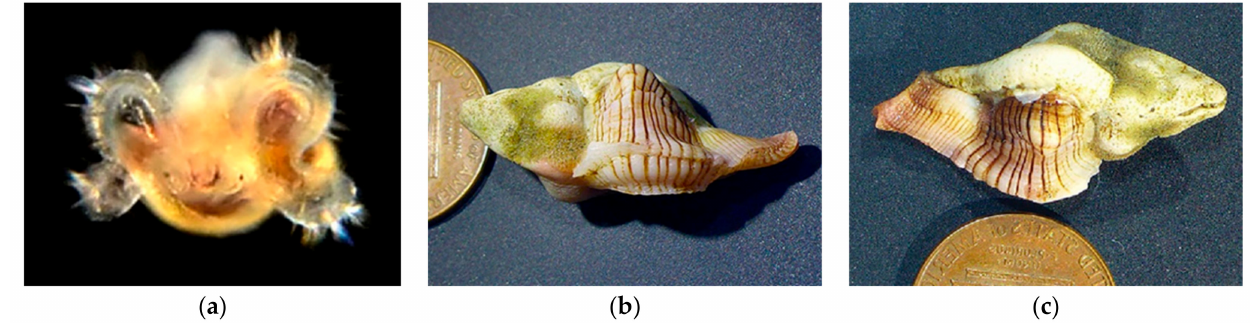
Figure 16. Family Muricidae. Festive Murex , Pteropurpura festiva (BIN ADF9780, n = 6 veligers, 3 adults). ( a ) Veliger BIOUG01229-H09 from Newport Beach, Harbor entrance; ( b ) Adult (lateral) CCDB-36354 G07 from Reef Point, Crystal Cove State Park; ( c ) Adult (lateral) CCDB-36354 G09 from Pelican Point, Crystal Cove State Park. Family Olivellidae Troschel, 1869: The Dwarf Olives A family of small predatory snails (Figure 17) with smooth, shiny, elongated shells.